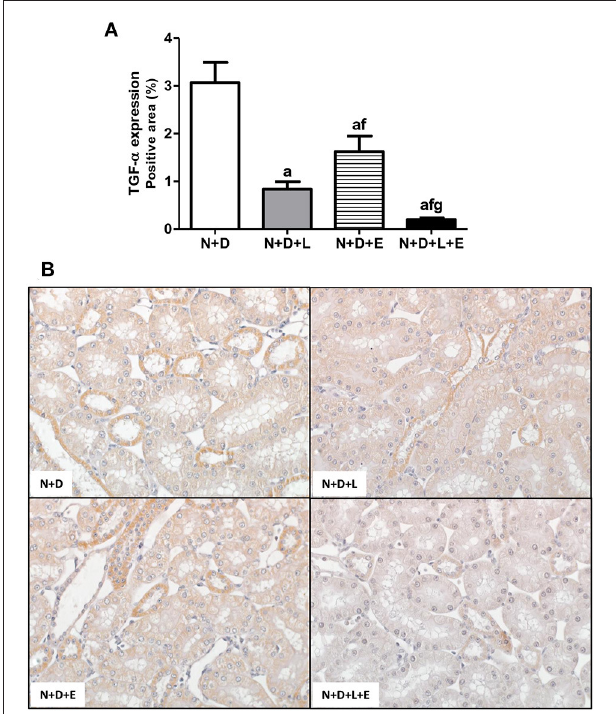
FIGURE 4 | Immunohistochemical analysis of transforming growth factor α (TGF- α ) expression in the renal cortex. (A) Bar graph of TGF- α expression evaluated 60 days after 5/6 nephrectomy in vitamin D-deficient rats treated with losartan, erlotinib or losartan + erlotinib. (B) Representative photomicrographs of immunostaining for TGF- α in the renal cortex from a N + D, N + D + L, N + D + E, and N + D + L + E rat (x400). Note that TGF- α expression is significantly lower in the N + D + L + E than in the other groups. Data are mean ± SEM. a p < 0.001 vs. N + D; f p < 0.05 vs. N + D + L; g p < 0.001 vs. N + D + E. N, 5/6-nephrectomized rats; D, vitamin D-deficient rats; L, losartan-treated rats; E, erlotinib-treated rats; L + E, rats concomitantly treated with losartan + erlotinib. N + D ( n = 10); N + D + L ( n = 8); N + D + E ( n = 7); N + D + L + E ( n = 10).